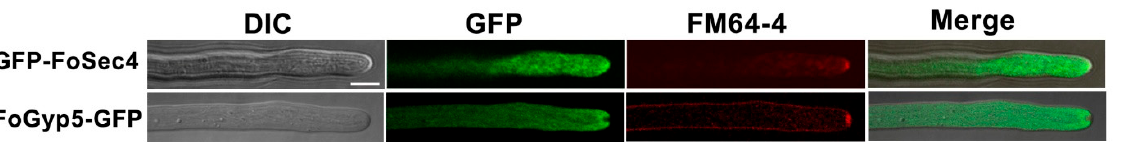
Figure 2. Subcellular localization of GFP-FoSec4 and FoGyp5-GFP in the hyphae of F. odoratissi- mum . Shown are confocal fluorescence images indicating that the two proteins are located and well distributed in the cytoplasm but exhibit different patterns in the hyphal tips. GFP-FoSec4 colocal- ized with Spitzenkörper, but FoGyp5-GFP accumulated at the periphery of Spitzenkörper. Bars = 10 μ